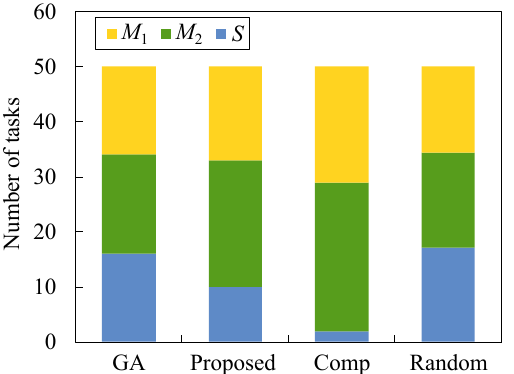
Figure 9. Number of tasks allocated to each server in the case of N 1 = 50, τ = 0.2, and λ = 2.0.